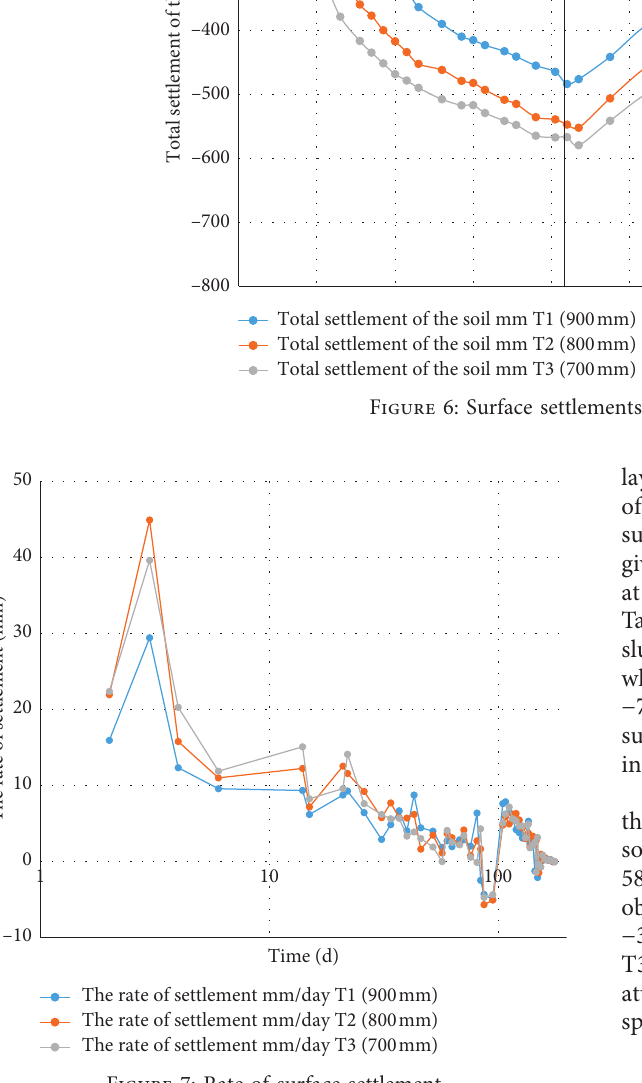
Figure 7: Rate of surface